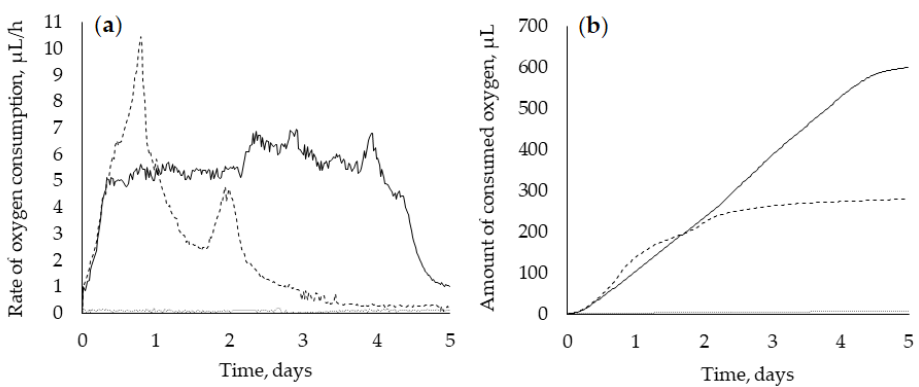
Figure 3. The rate of oxygen consumption ( a ) and amount of oxygen consumed ( b ) by R. rhodochrous IEGM 757 during OA biotransformation ( ). Biotic ( ) and abiotic ( ) controls.